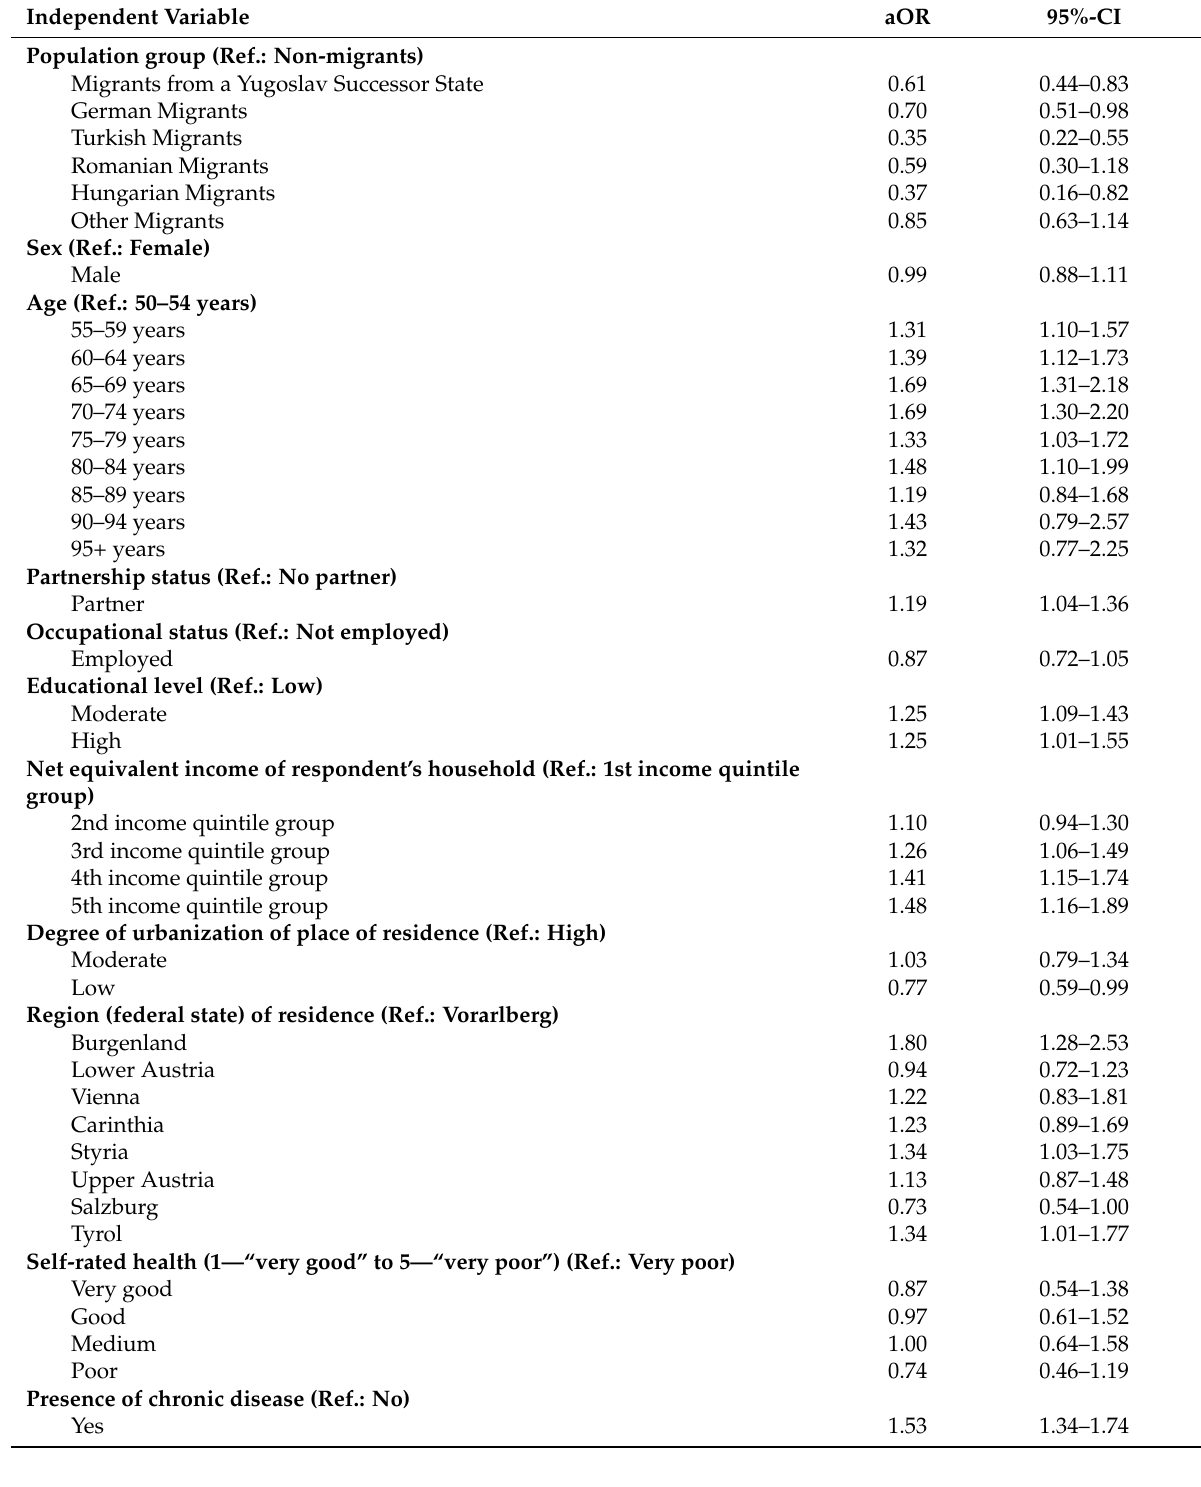
Table 2. Results of the multivariable logistic regression model with utilization of the fecal occult blood test as the dependent variable. Adjusted odds ratios (aOR) and 95% confidence